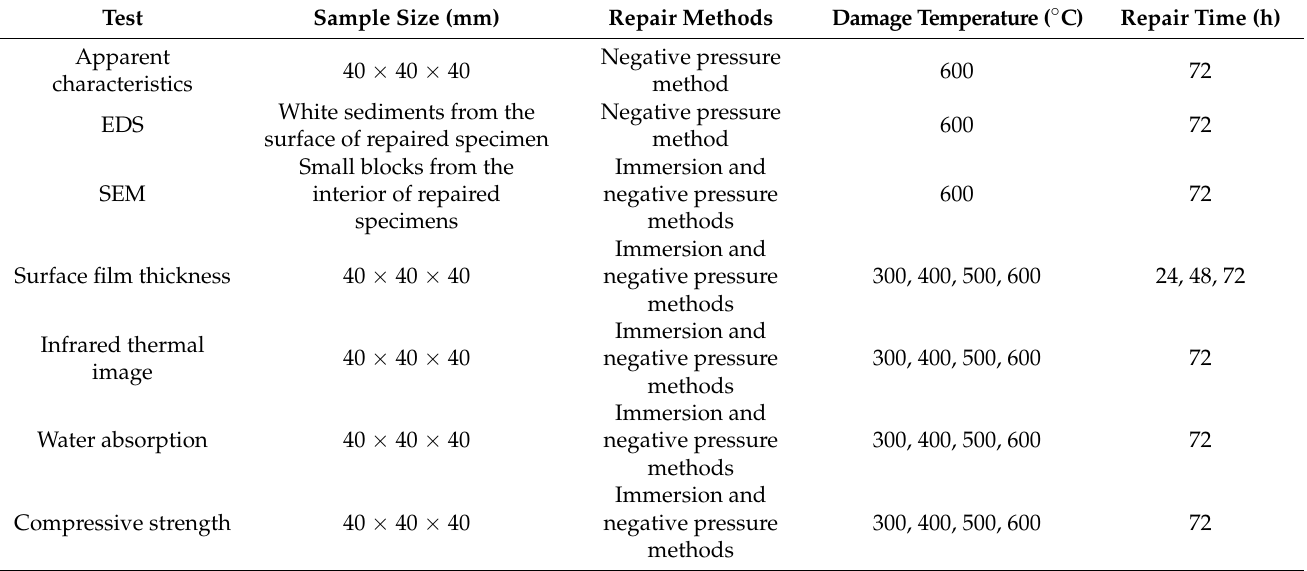
Table 2. Specimens’ information for different